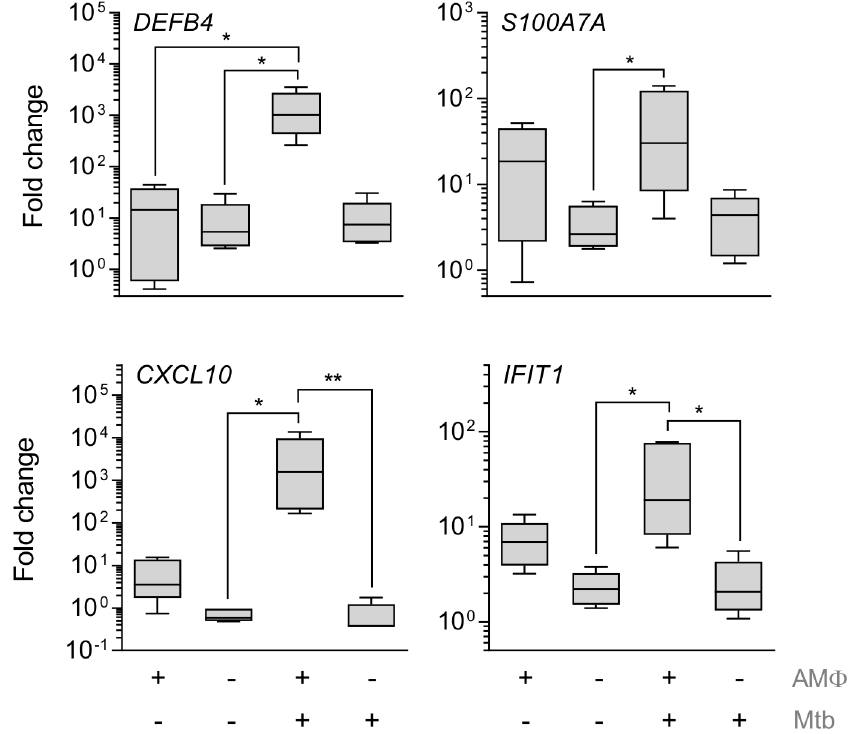
Fig 4. Mtb-infected alveolar macrophages drives gene expression in PBECs. Cell-free conditioned medium from Mtb-infectedand uninfectedAM Φ , alongsidethe appropriate culture medium controls was added to PBECs. After 24h gene expressionwas measuredby RT-PCR. Gene expressionis shown as fold changeover unstimulated PBECs (n = 5). Friedmantest with Dunn’spost-test was used to compare stimulations. Boxplots show median and range. * p < 0.05; ** , p < 0.01or the exact p-value are given.